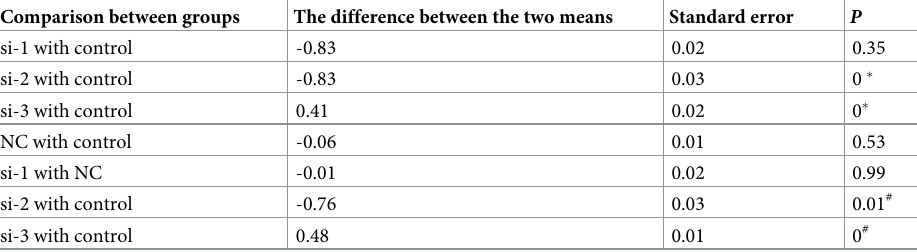
Table 4. qPCR detection of the relative expression level of mRNA in each group of cells.